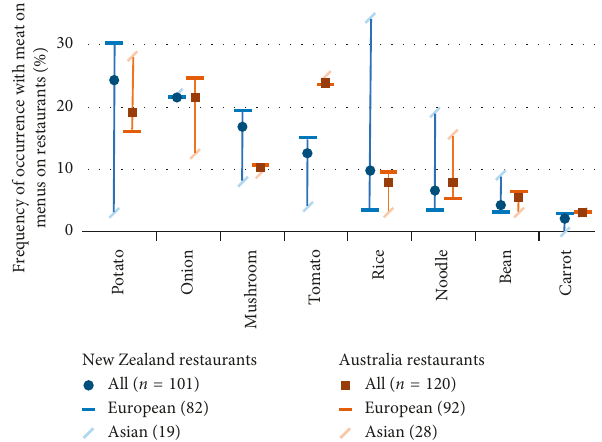
Figure 1: Experiment 5: summary of results from the online survey of accompaniments to meat, as described on menus in New Zealand and Australia